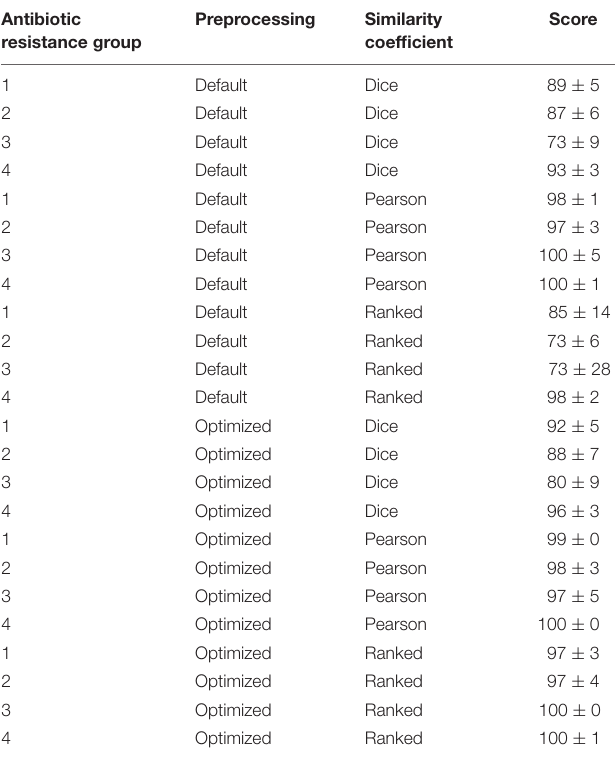
TABLE 3 | Effect of MALDI-TOF MS spectrum processing parameters on AMR detection in strains of C. jejuni. Antibiotic resistance